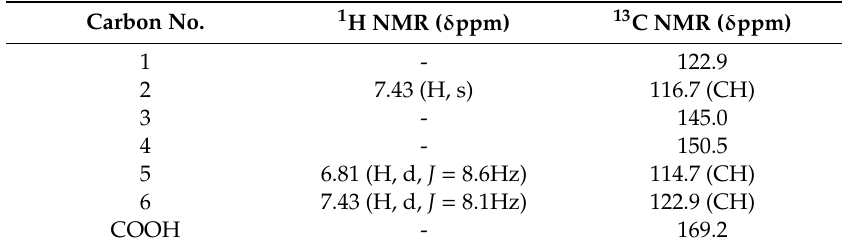
Table 4. The 1 H and 13 C NMR spectral data (recorded in CD 3 OD) of BV4 fraction isolated from Bauhinia variegata L.